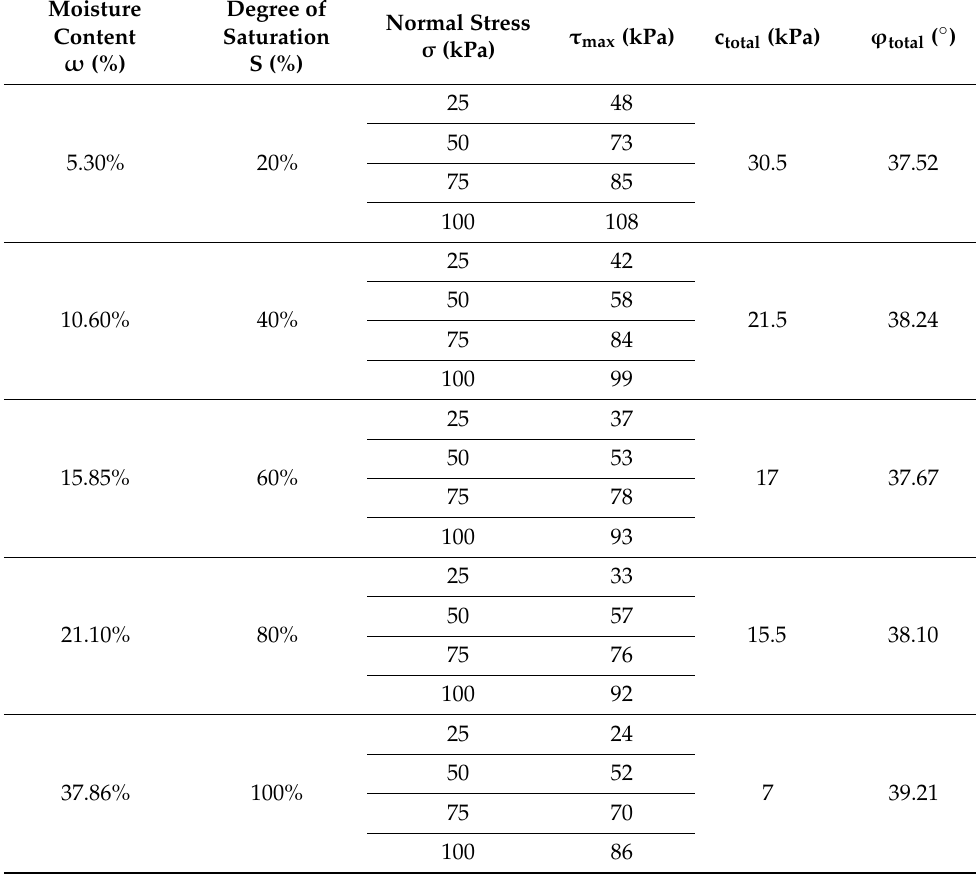
Table 3. Shear strength index of Yellow River